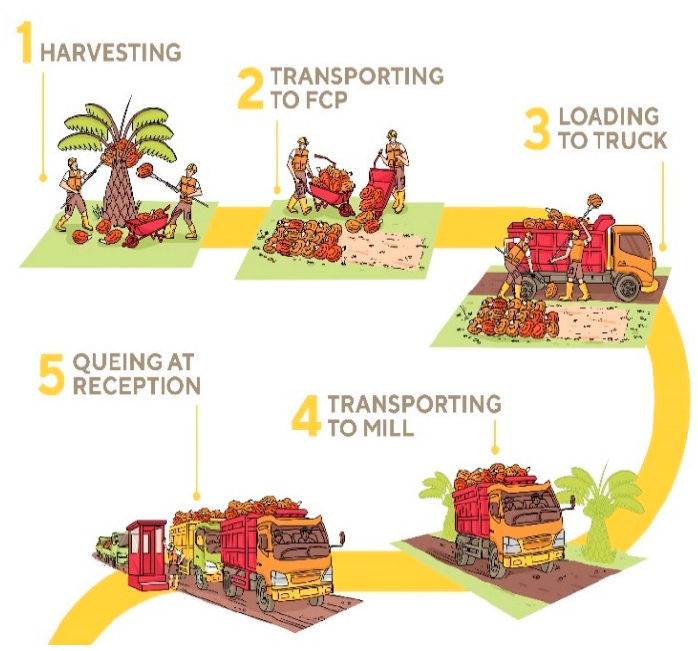
Figure 4. Use case scenario: The business process of FFB transportation.